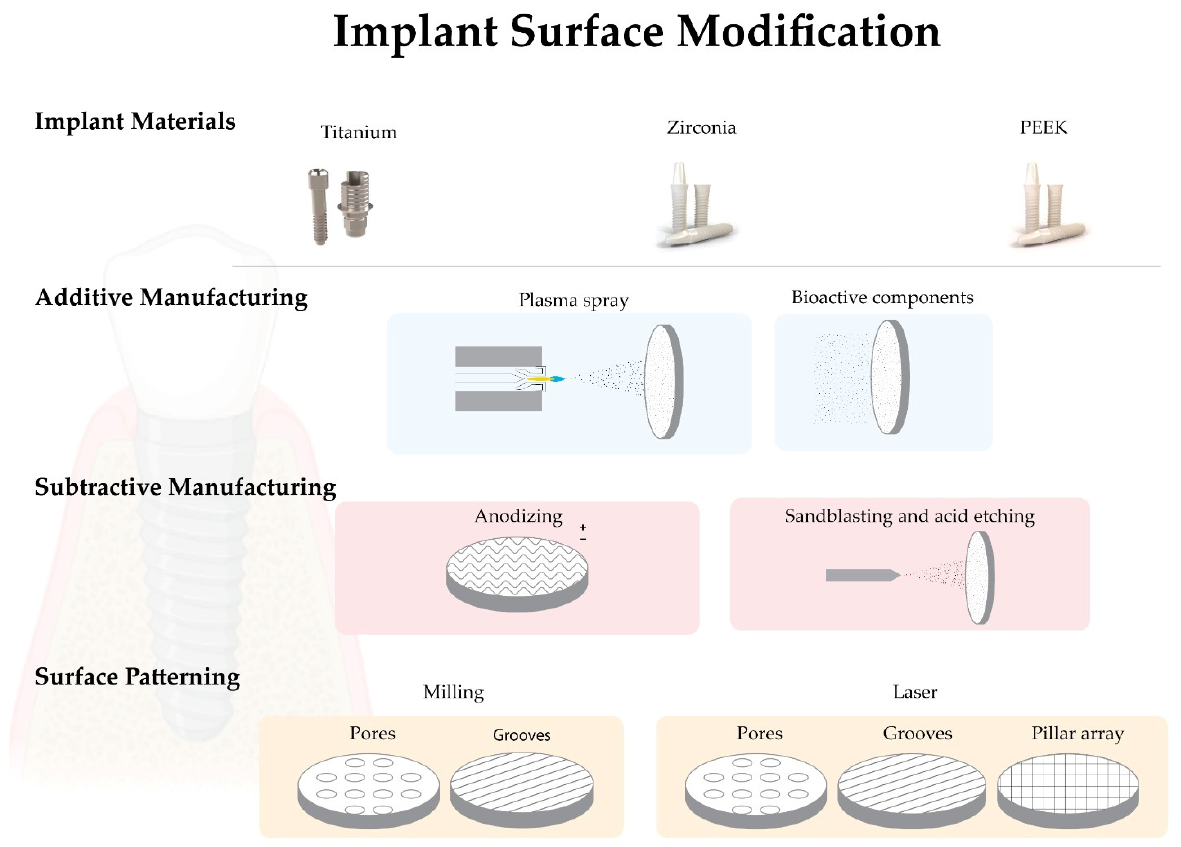
Figure 1. Schematic image of the most relevant biomimetic surface modification